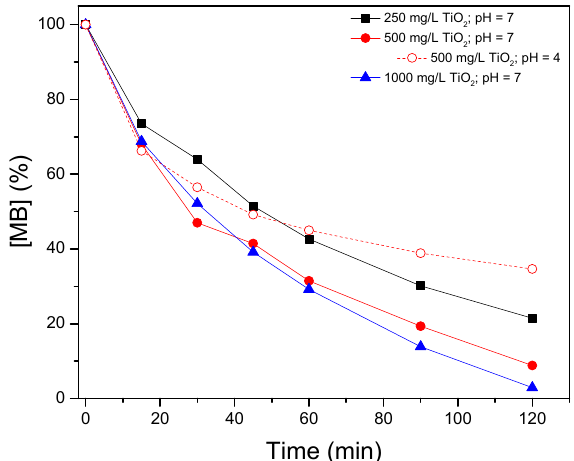
Figure 2. Influence of TiO 2 dosage and pH (4 and 7) in MB discoloration through TiO 2 /UV-A.